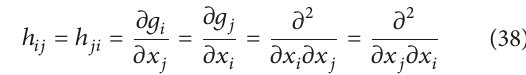
Figure 11: Comparison between measured and estimated open circuit voltage (V oc and V mes